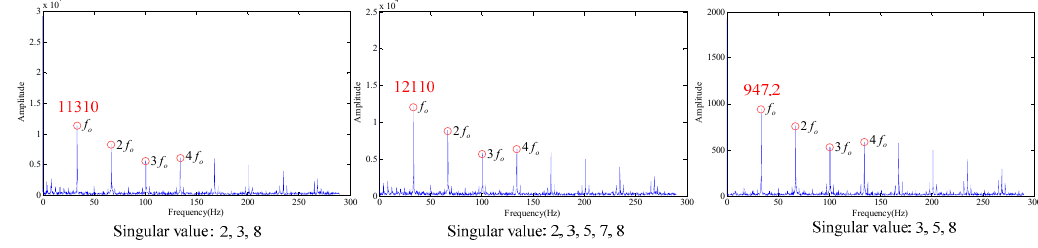
Figure 6. Envelope spectrum under different singular values.